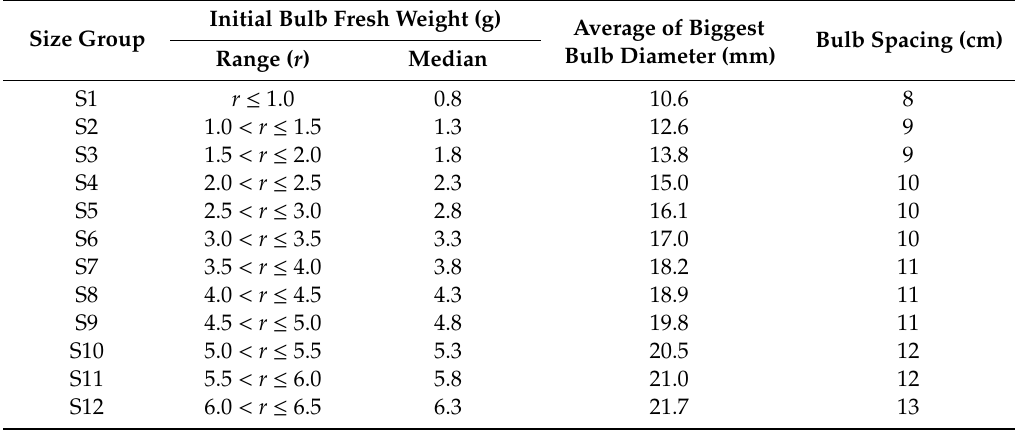
Table 1. Characteristics of bulb size groups and bulb spacing in the field